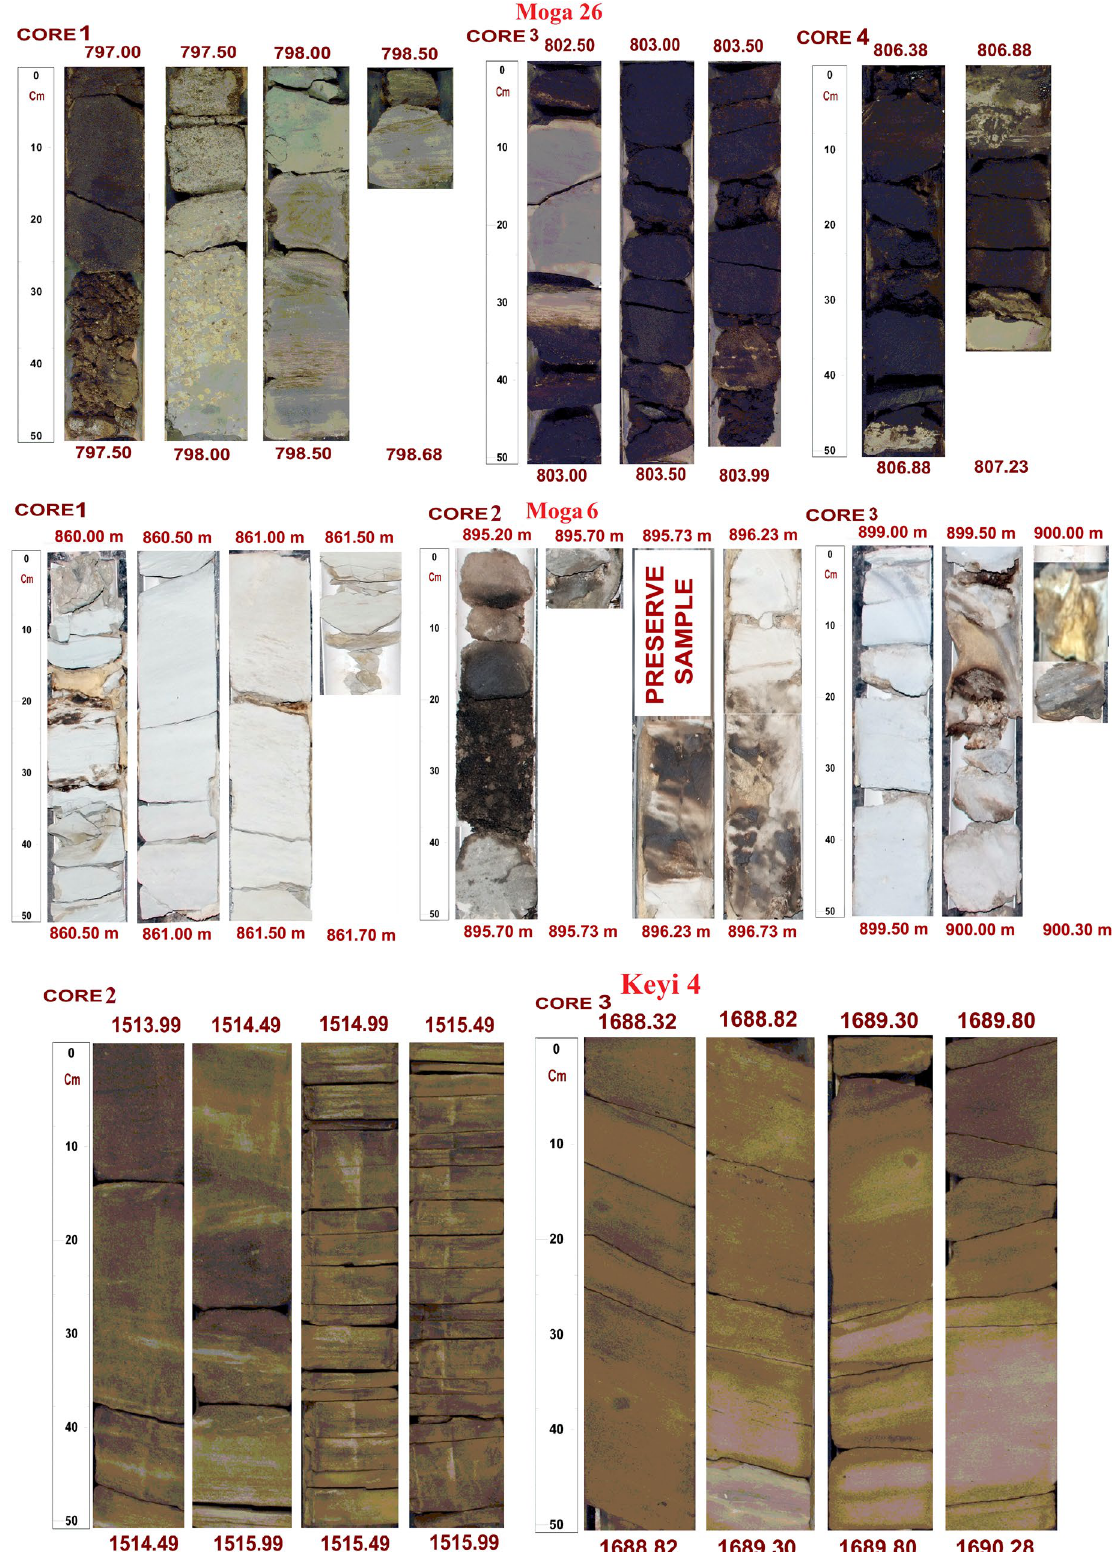
Figure 5. Conventional cores photos showing the studied core form different wells. Eight (8) different major lithofacies types have been recognized form these photos (Tables 2 and